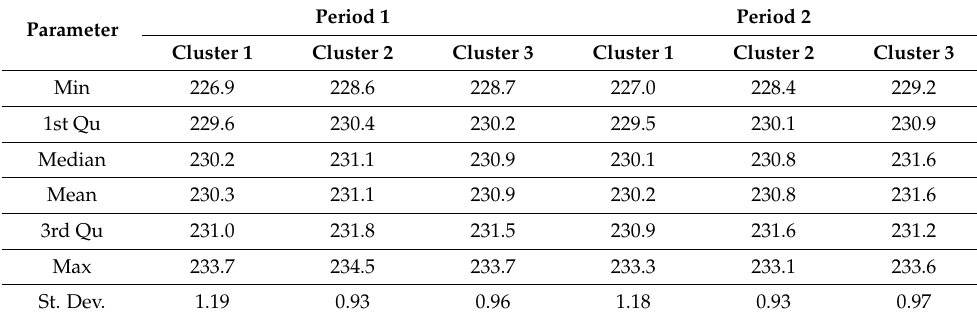
Table 7. Descriptive statistics of the voltage in phase L3 at the tested measuring point.